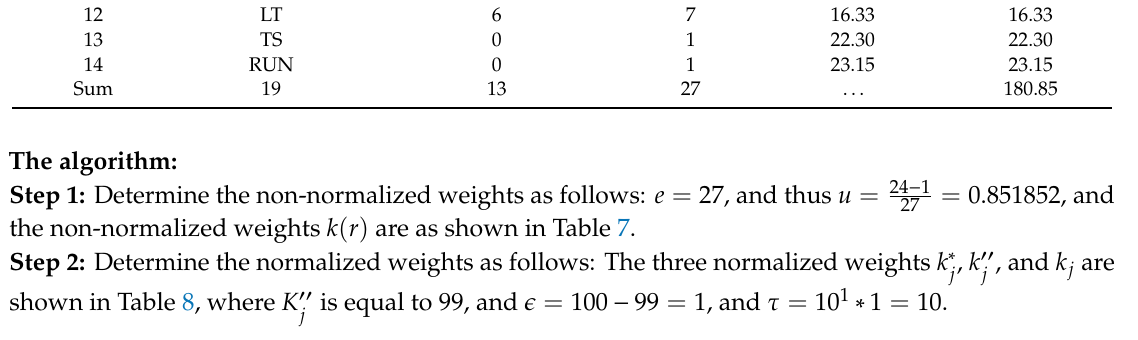
Table 8. Normalized weights for w = 1 and z =